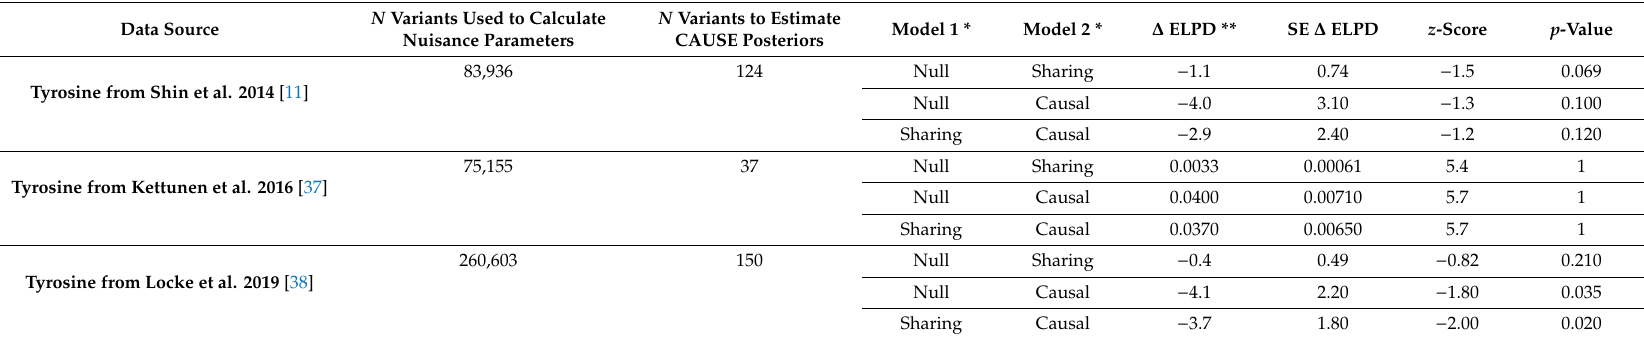
Table 4. Results from CAUSE MR for tyrosine with type 2